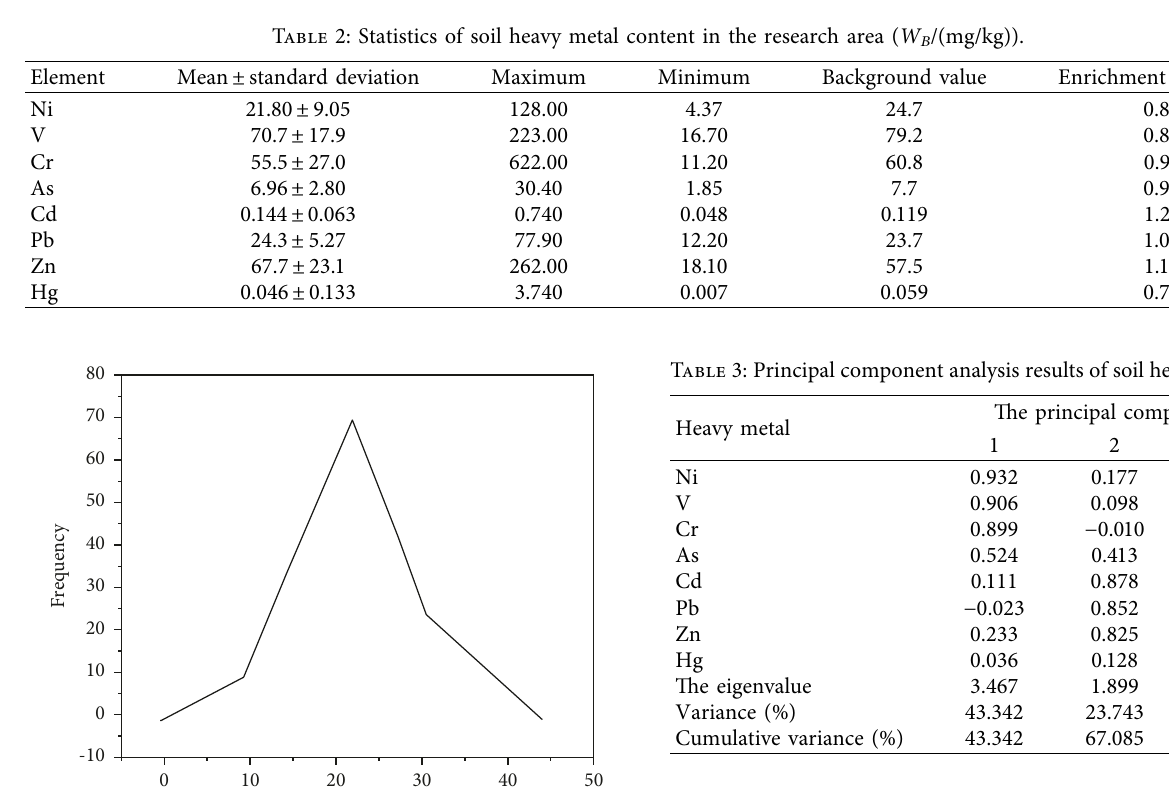
Figure 2: Histogram and box diagram of the heavy metal content distribution.